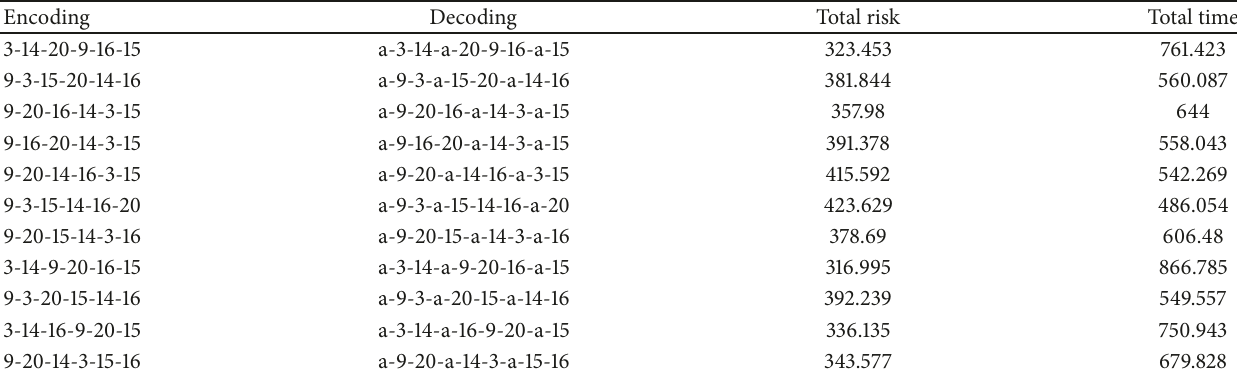
Table 7: Pareto solution set of robust control parameters Γ =20 for distribution center a.